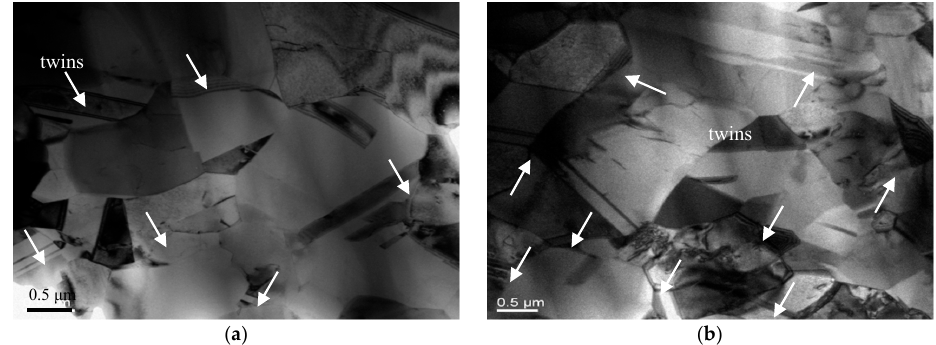
Figure 12. TEM images of the shear zone at the blanking speed of ( a ) SPM 300 and ( b ) SPM 3000. During the blanking process, dislocations gradually tangle together to form dislocation cells. As the blanking deformation continues, the number of dislocation cells increases and the size of dislocation cells decreases. When the dislocation density in the cell walls further increases,